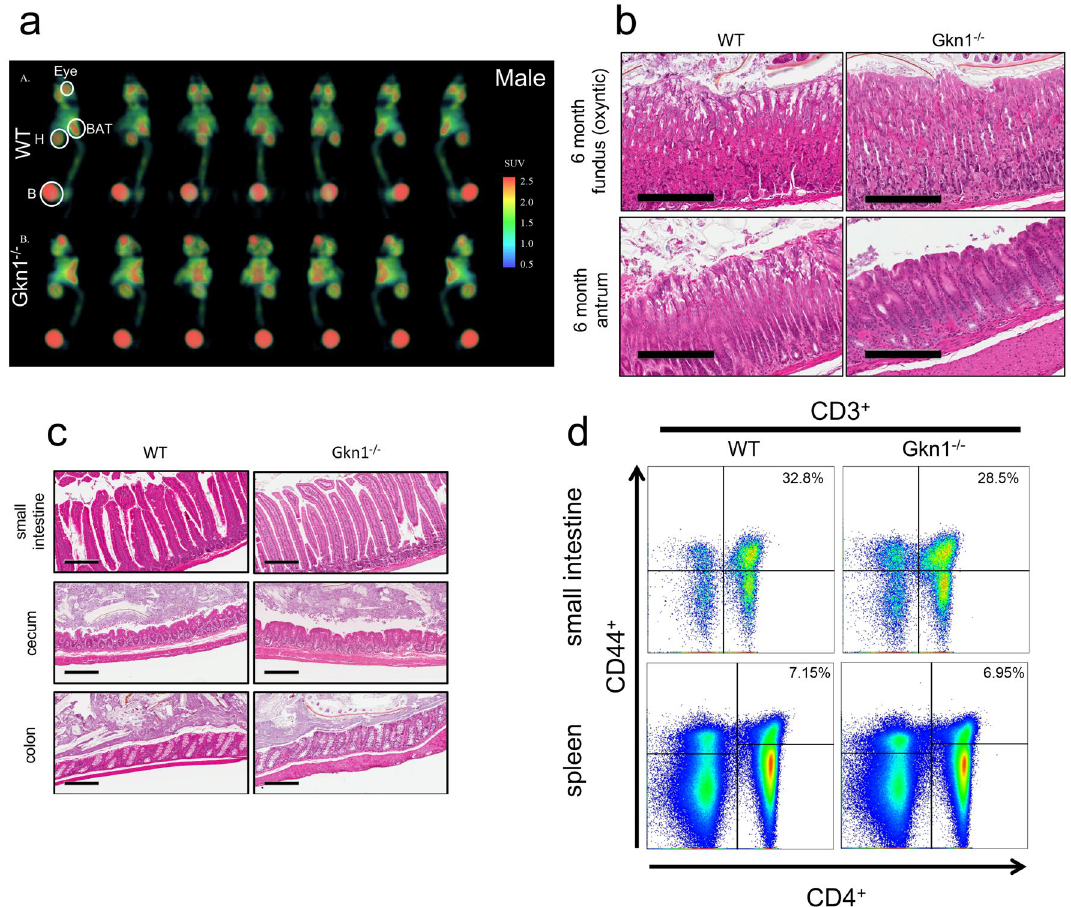
Figure 5. GKN1 −/− do not exhibit signs of cancer or inflammation. ( a ) Male WT and GKN1 −/− were imaged using PET scans. Highlighted areas are as follows: BAT – brown adipose tissue, H – heart, B – bladder. ( b ) Histology of aged (6 month old) antrum and fundus in WT and GKN1 −/− mice. ( c ) Histology of the small intestine, cecum and colon of WT and GKN1 −/− mice. ( d ) Flow cytometry analysis of small intestine and spleen cells gates on CD44 + and CD4 + (n =